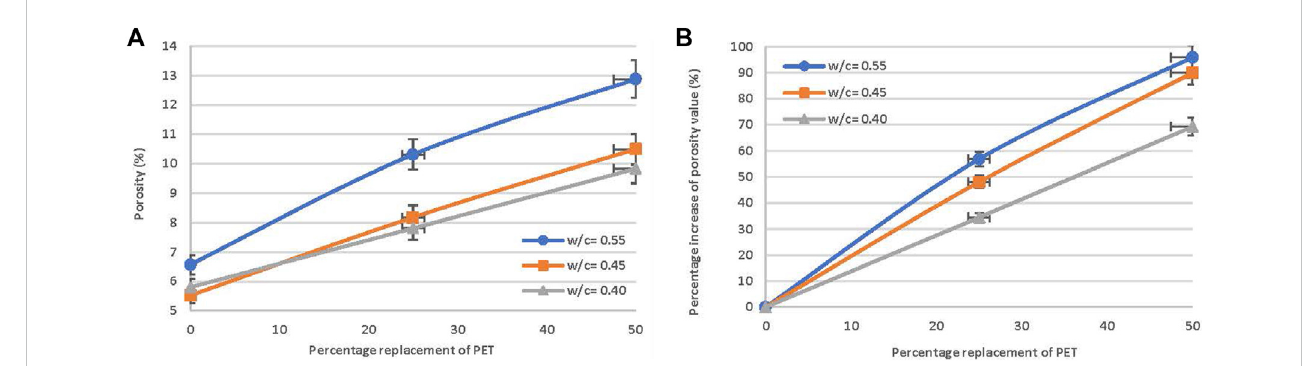
FIGURE 10 Porosity test results for different ratios of PET and w/c: (A) porosity value; and (B) increase percentage.